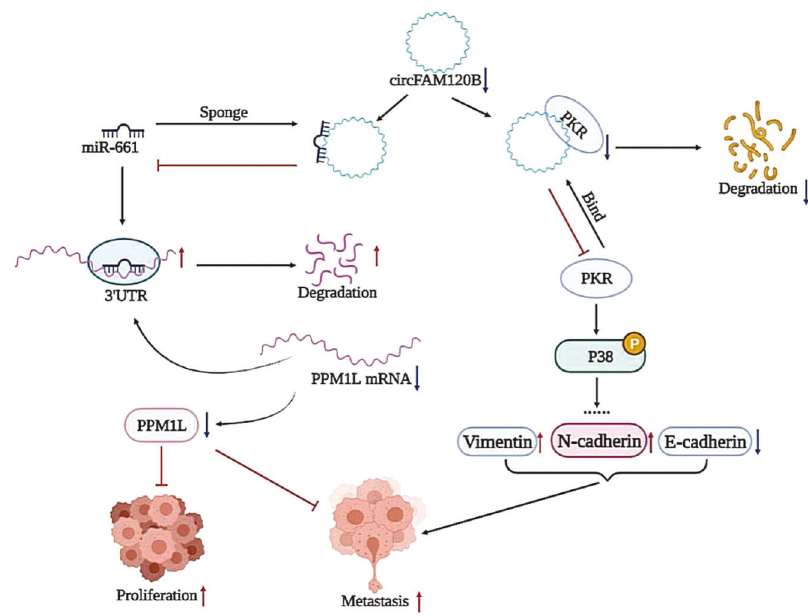
Fig. 7 circFAM120B acts as a tumor suppressor via the circFAM120B/miR-661/PPM1L axis and PKR/p38 MAPK/EMT pathway. Schematic representation of the molecular pathway of circFAM120B-mediated